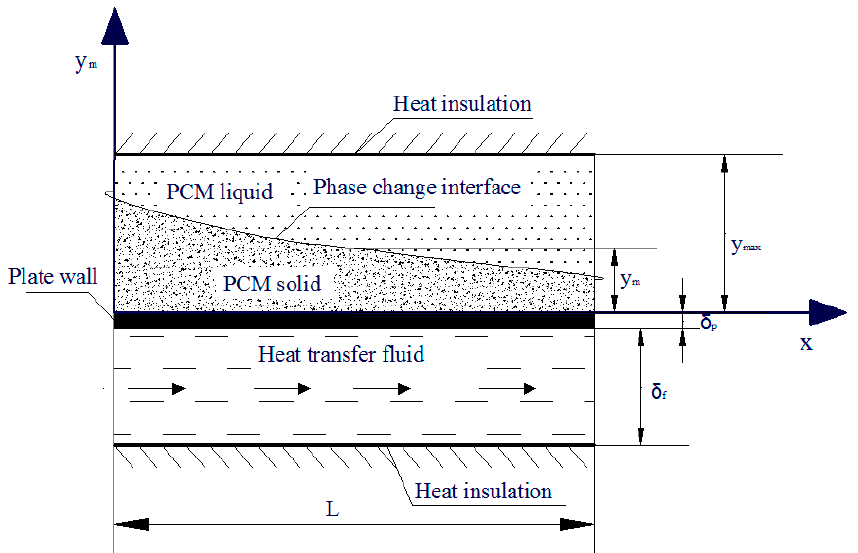
Figure 7. Mathematical model of the phase-change thermal storage unit.